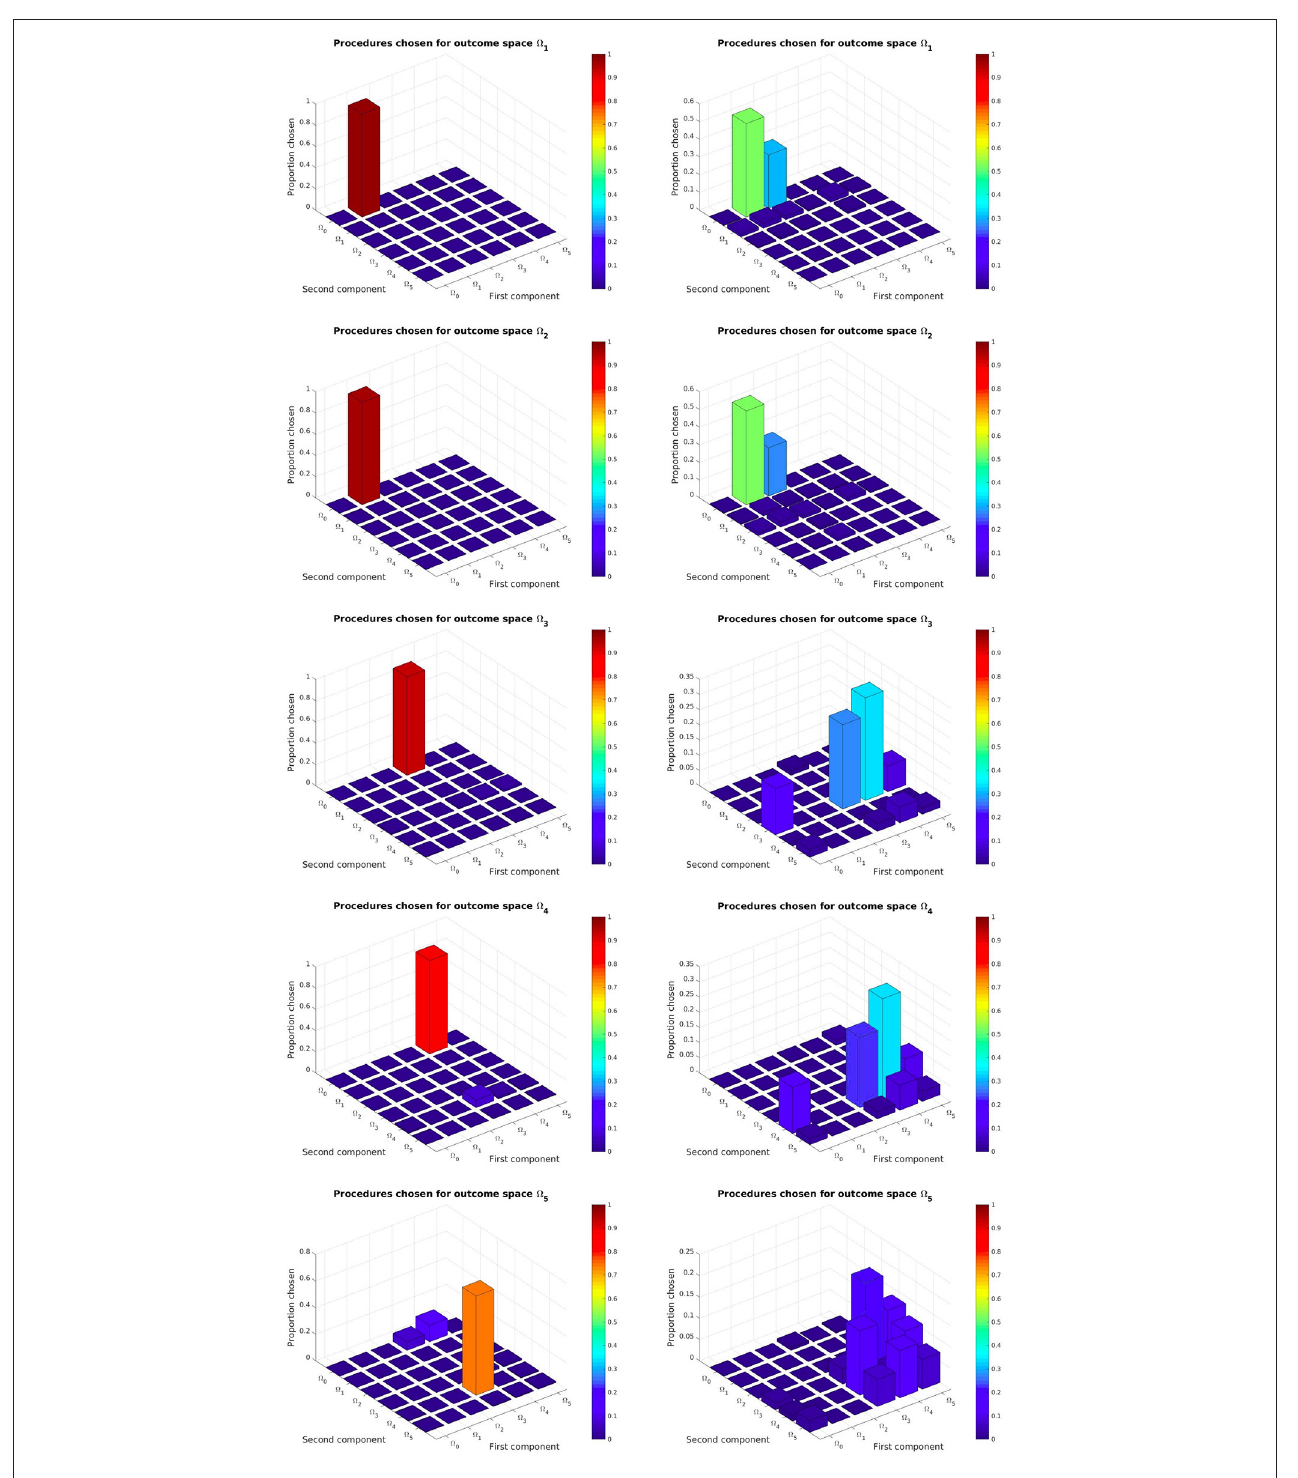
FIGURE A1 | Task hierarchy discovered by the SGIM-PB (left side) and IM-PB (right side) learners: this represents for each complex outcome space the percentage of time each procedural space would be chosen.